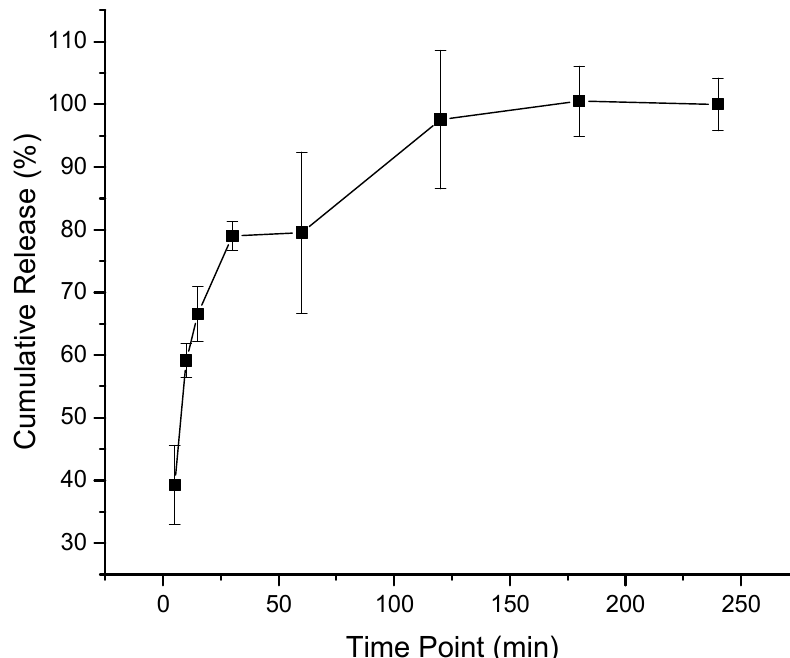
Figure 4. Melittin-loaded fibers release in PBS (pH 5.5), showing an initial burst release of 40% after 5 min and a complete drug release after 180 min. The results are presented as average ± SD of independent triplicates.